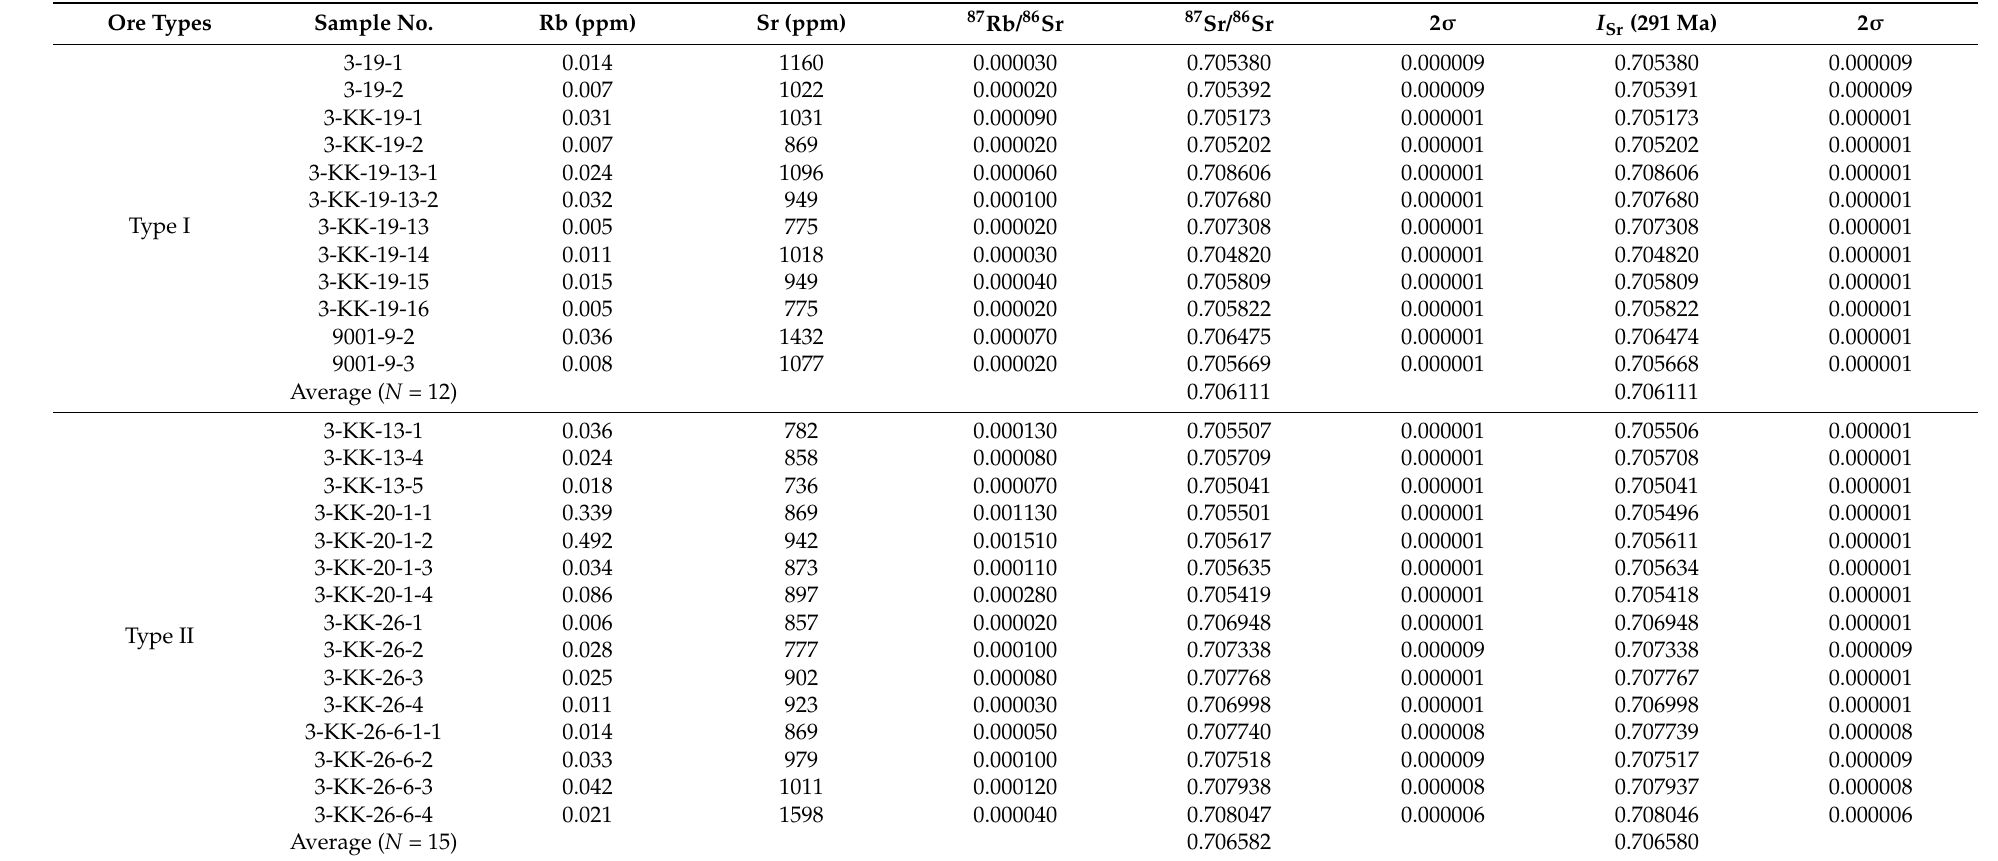
Table 3. Results of in situ Sr isotopic analysis of scheelite from the Doranasai gold